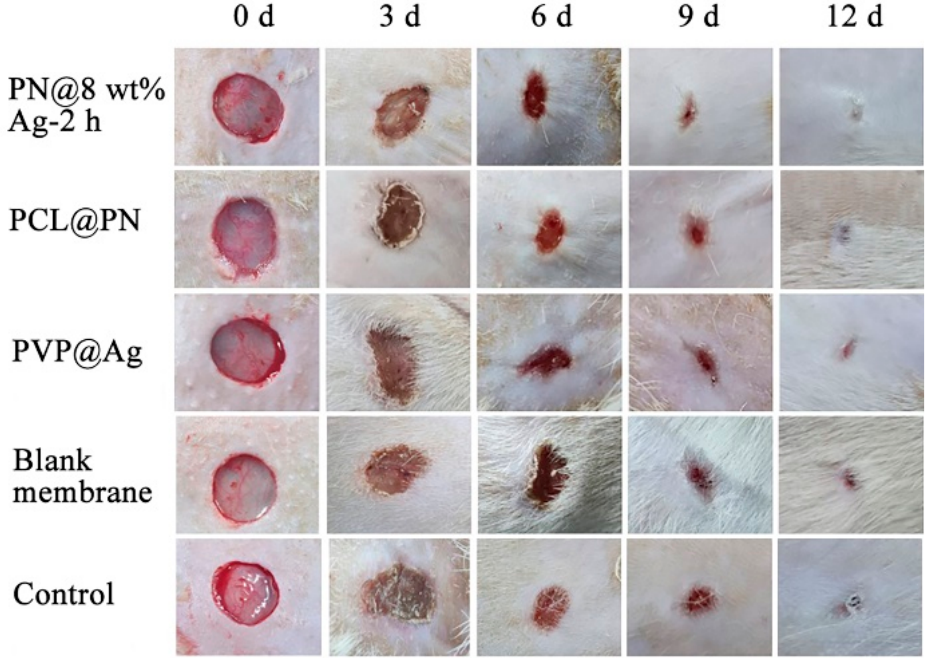
Figure 7. The effects of skin wound healing of Sprague Dawley mice in different treatment groups (PN@8 wt%Ag-2 h group, PCL@PN group, PVP@Ag group, blank membrane group, and control group) at day 0, 3, 6, 9 and 12 after